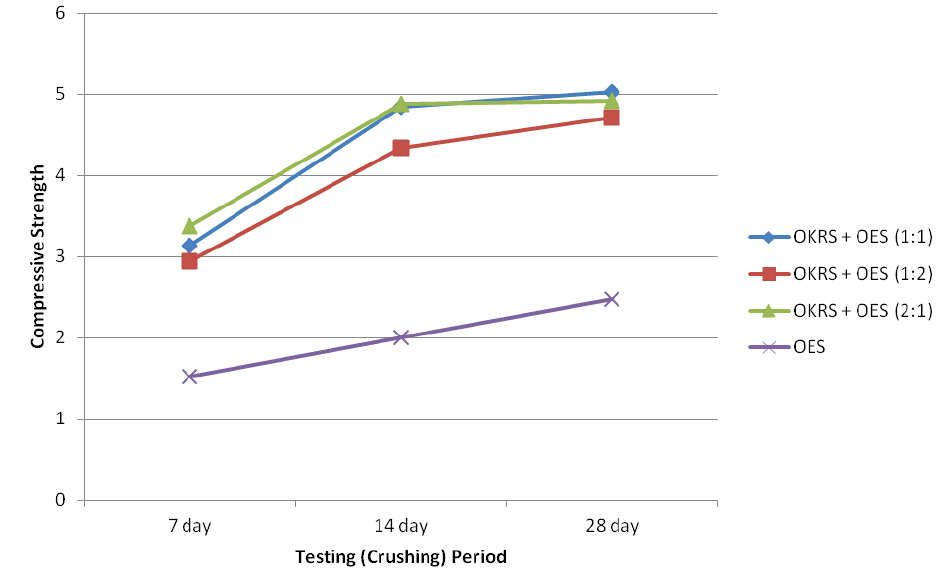
Figure 7. Compressive strength at 7, 14 and 28-day testing period for OES and its